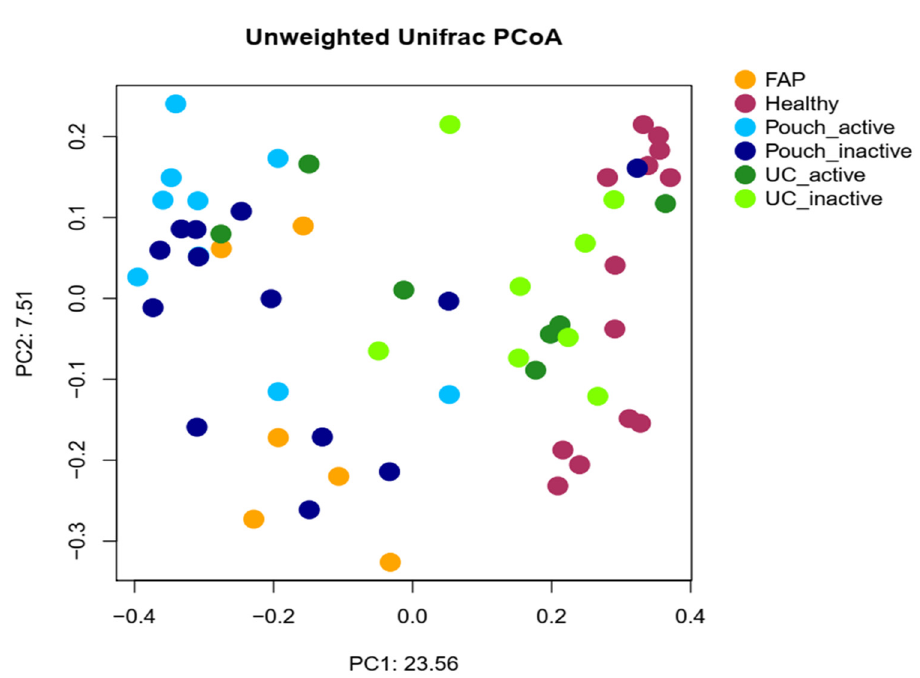
Figure 2. Principal coordinate analysis plot based on unweighted UniFrac distances showing the separation of different groups based on pairwise permANOVA test, except FAP from Pouch active and Pouch inactive groups, Pouch active from Pouch inactive group and UC active from UC inactive group. Sample sizes were 6, 13, 9, 13, 7 and 8 for FAP, Healthy, Pouch active, Pouch inactive, UC active and UC inactive groups, respectively. For details, see Table S3.